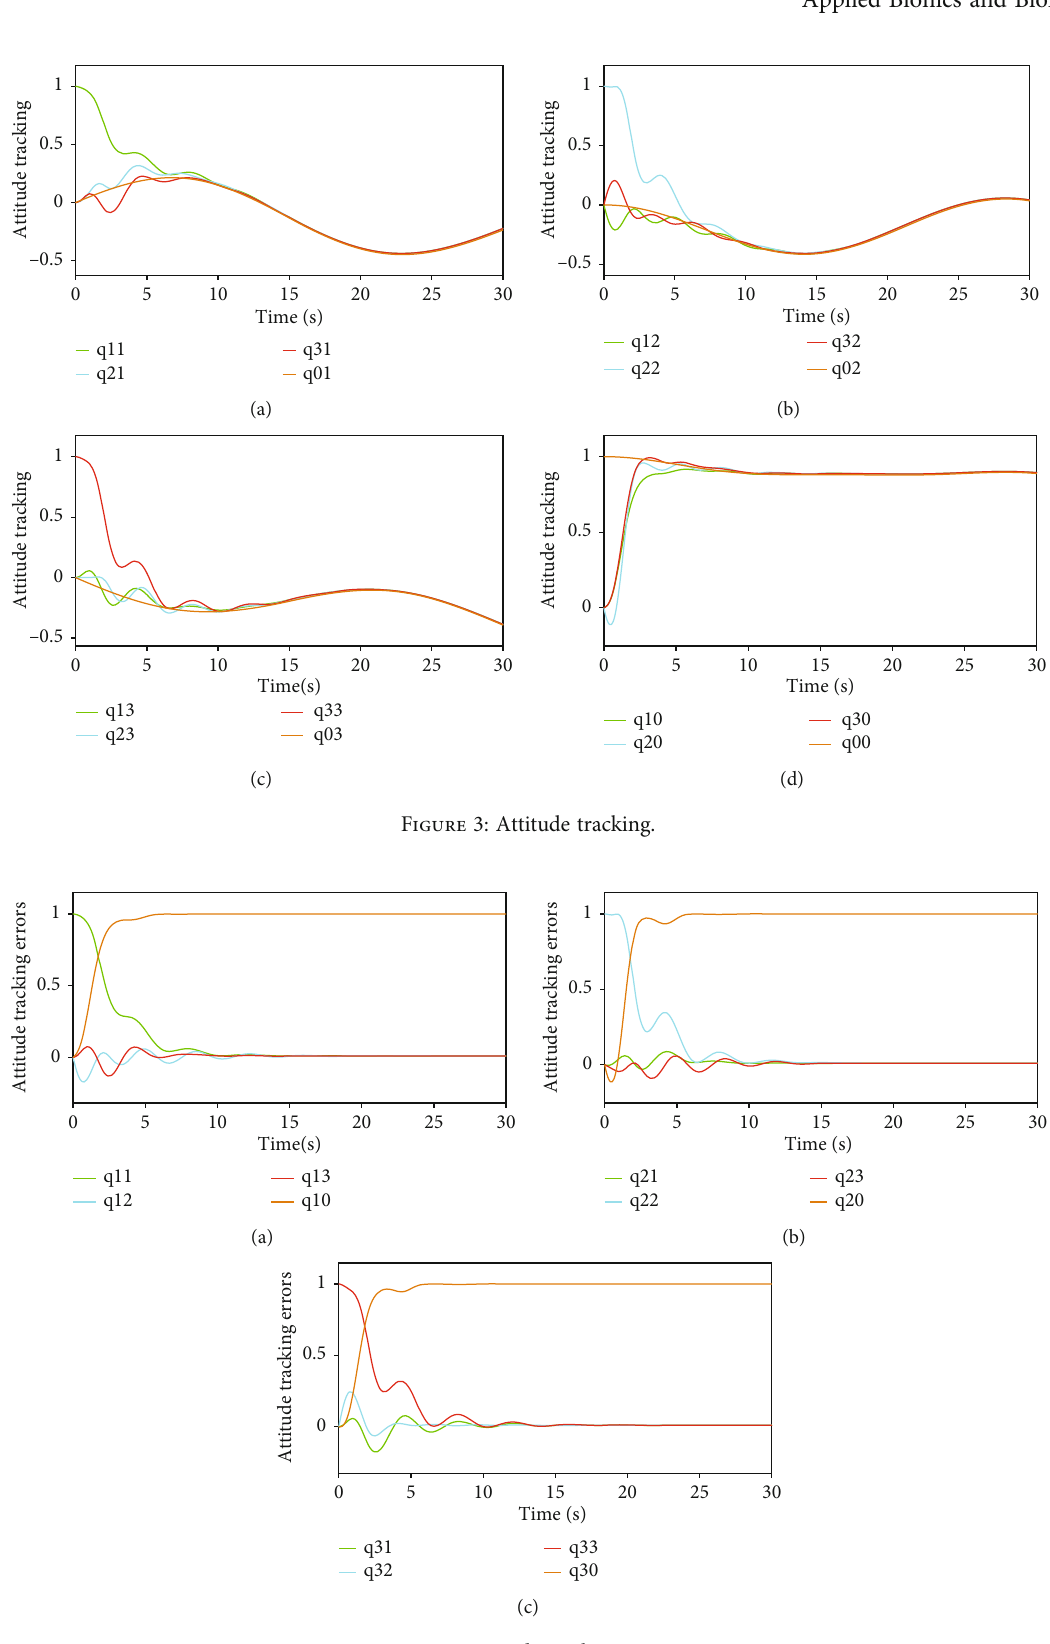
Figure 4: Attitude tracking